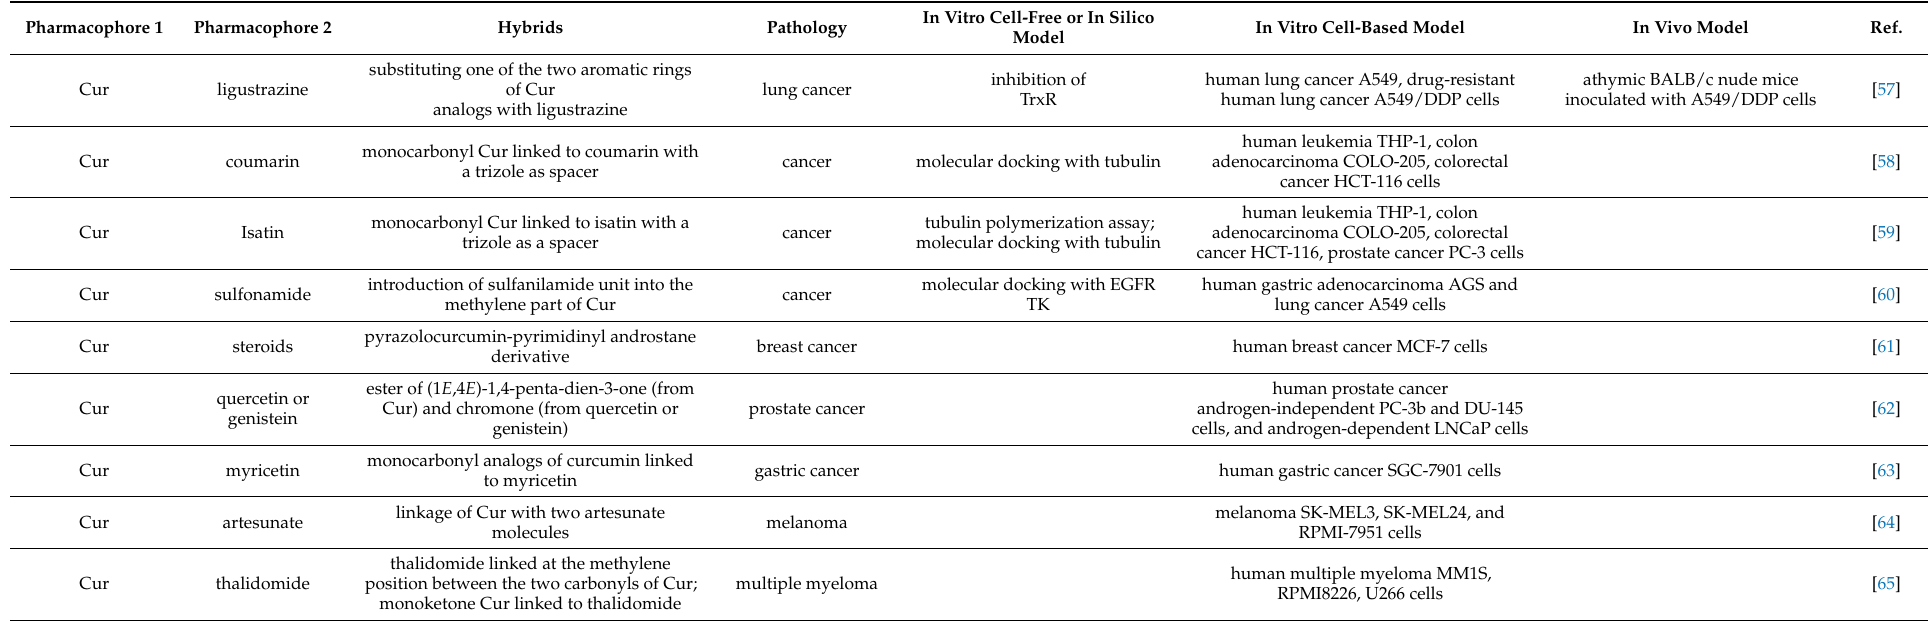
Table 2. Hybrid molecules derived from Cur and designed for potential employment in human